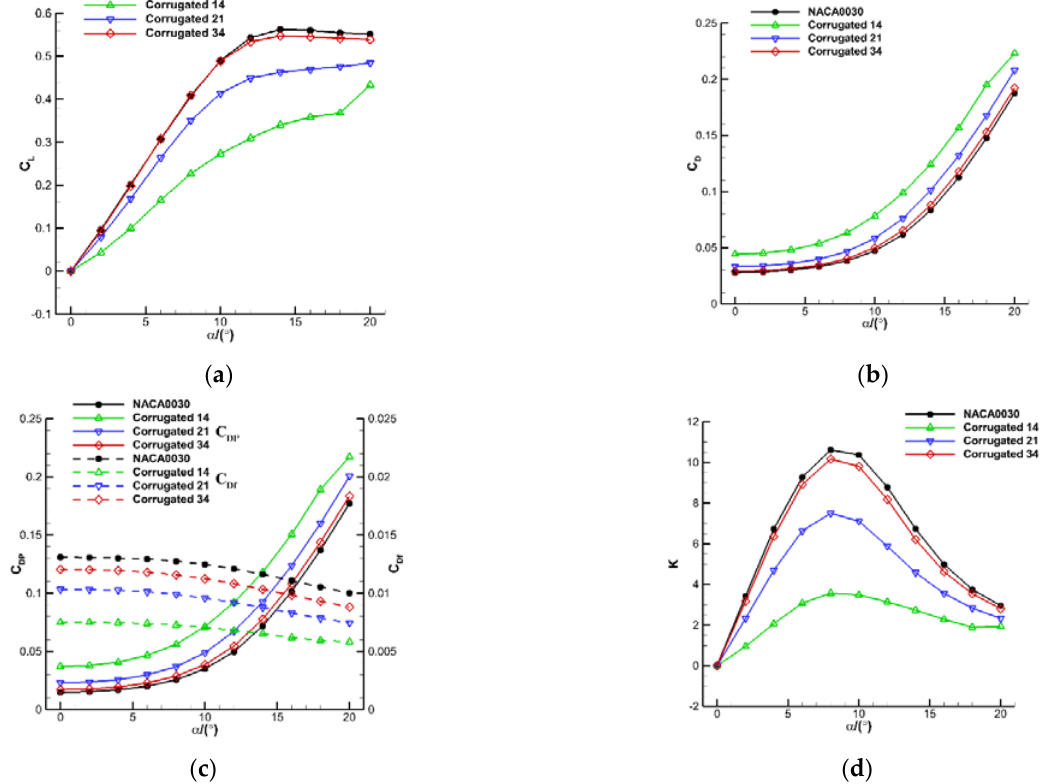
Figure 5. Time − averaged aerodynamic coefficients for corrugated airfoils and smooth airfoils: ( a ) Lift coefficient C L , ( b ) Drag coefficient C D , ( c ) Coefficients of pressure drag C DP and viscous drag C Df , ( d ) Lift − to − drag ratio K.